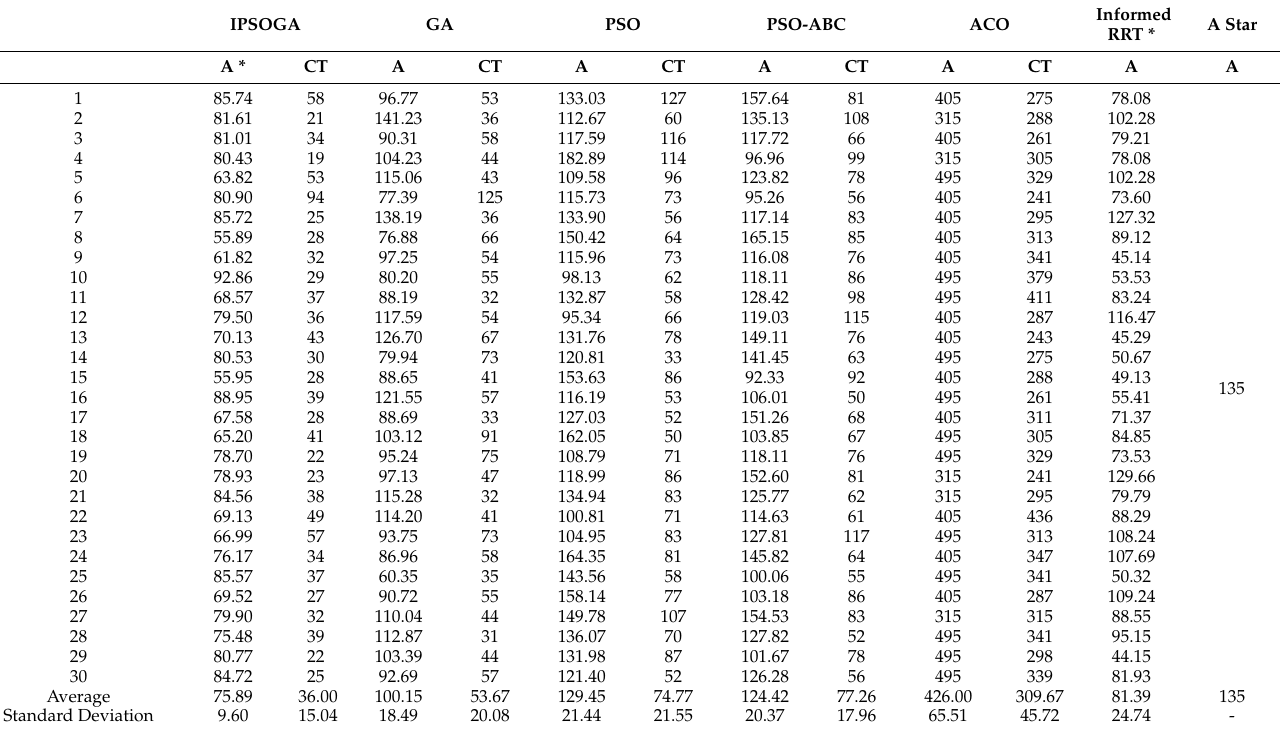
Table 5. Comparison of Algorithm Angle and Convergence Experimental Results (complex